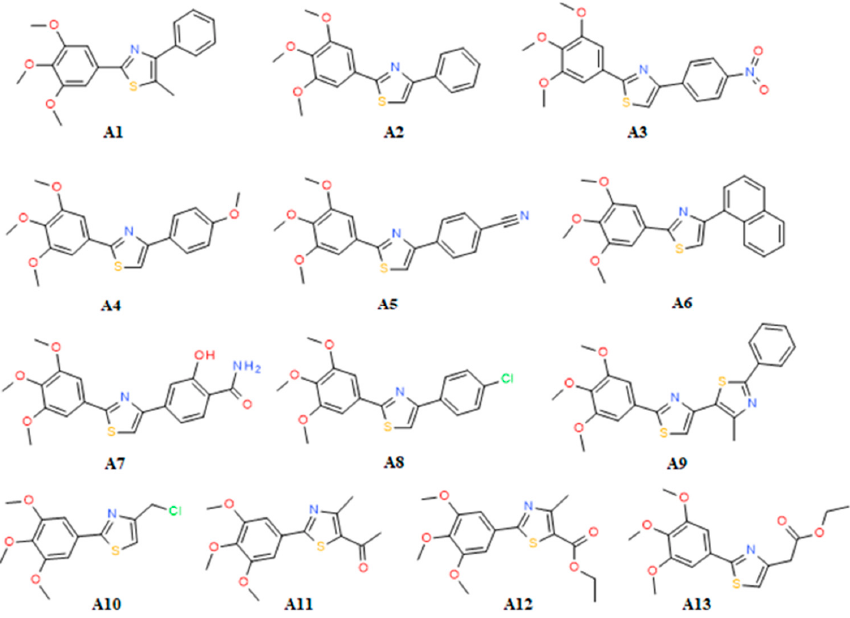
Figure 2. Chemical structures of the compounds A1 – 13 .